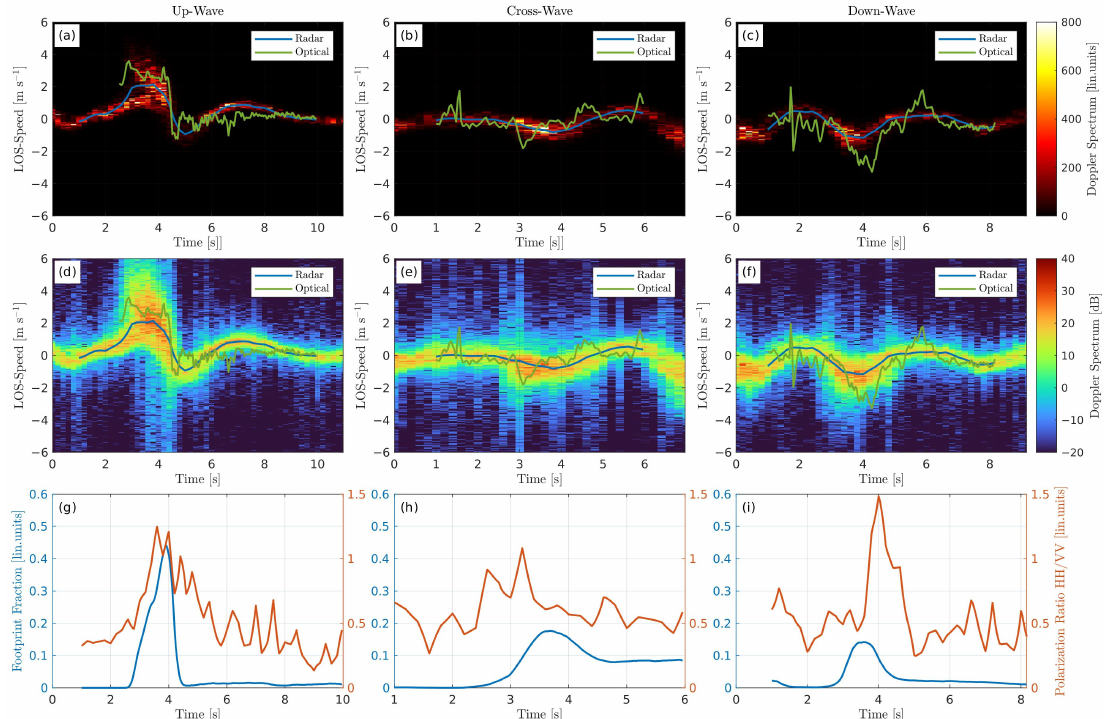
Figure 3. Three typical breaker records for ( left column ) up-wave, ( middle column ) cross-wave, and ( right column ) down-wave look geometry. ( Top row ) VV Doppler spectra in a linear scale with the estimated Doppler velocity (DV) and line-of-sight optical velocity (LOV); ( middle row ) the same as in the top row, but with Doppler spectra in the logarithmic scale; ( bottom row ) measured whitecap footprint fraction ( blue ) and polarization ratio (HH/VV, reddish ). The incidence angle is 40 ◦ , and the wind speed is 10 m s − 1